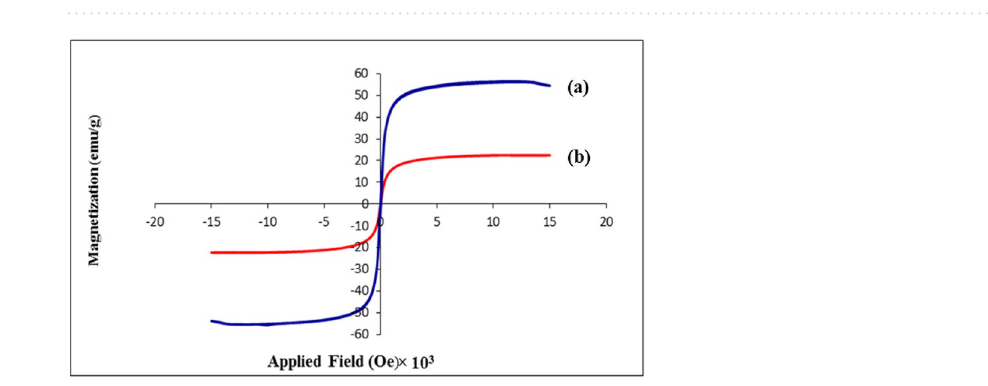
Figure 5. VSM magnetization curve of: ( a ) Fe 3 O 4 and ( b ) Fe 3 O 4 @SiO 2